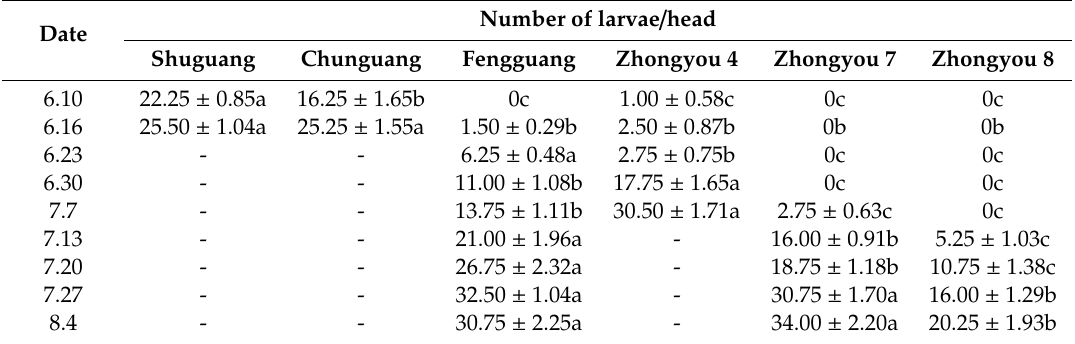
Table 4. The amount of larvae of D. suzukii on sliced nectarine varieties on the same collection